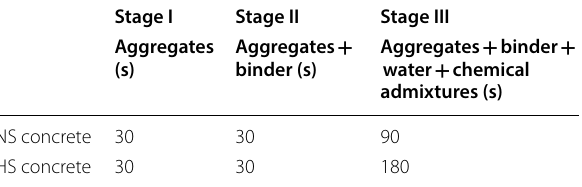
Table 4 Mixing procedures and time for RFA concrete. Table 5 Air content and slump measurement